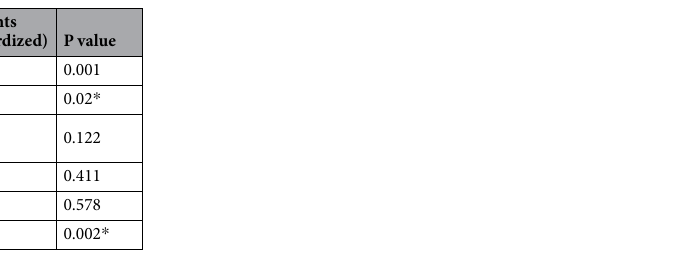
Table 3. Linear regression model fitting DMFS to the independent variables. * p <